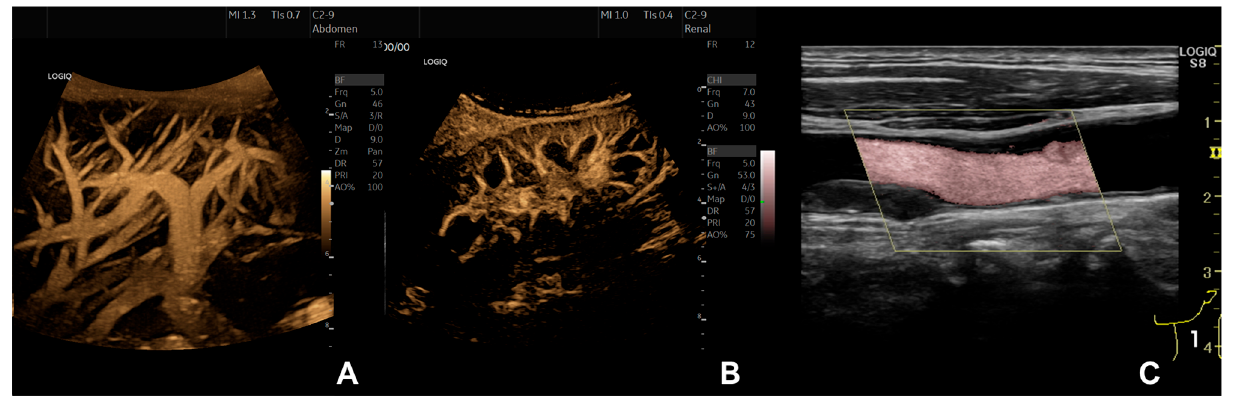
Figure 2. Examples of B-Flow ultrasound imaging of the liver ( A ), kidney ( B ), and carotid artery ( C ). Used with permission of GE Healthcare.